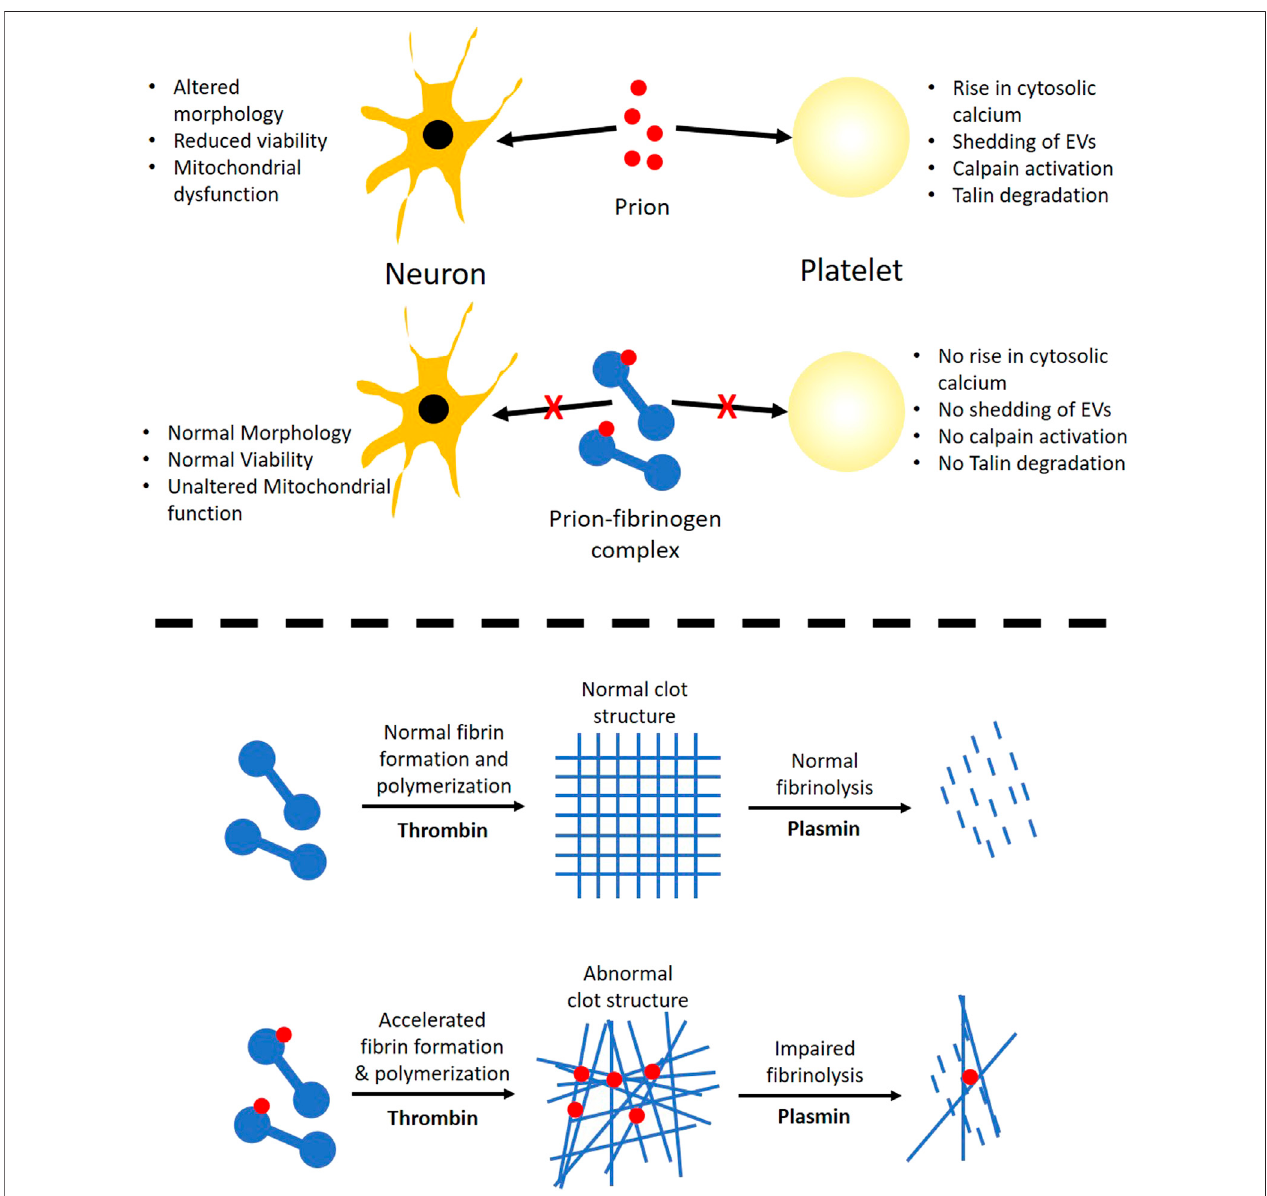
FIGURE7| Schemedepictingtheroleofprion- fi brinogencomplexinmitigationofprion-mediatedplateletactivation/neurotoxicity(upperpanel),andmodulationof fi brin clot dynamics (lower panel).